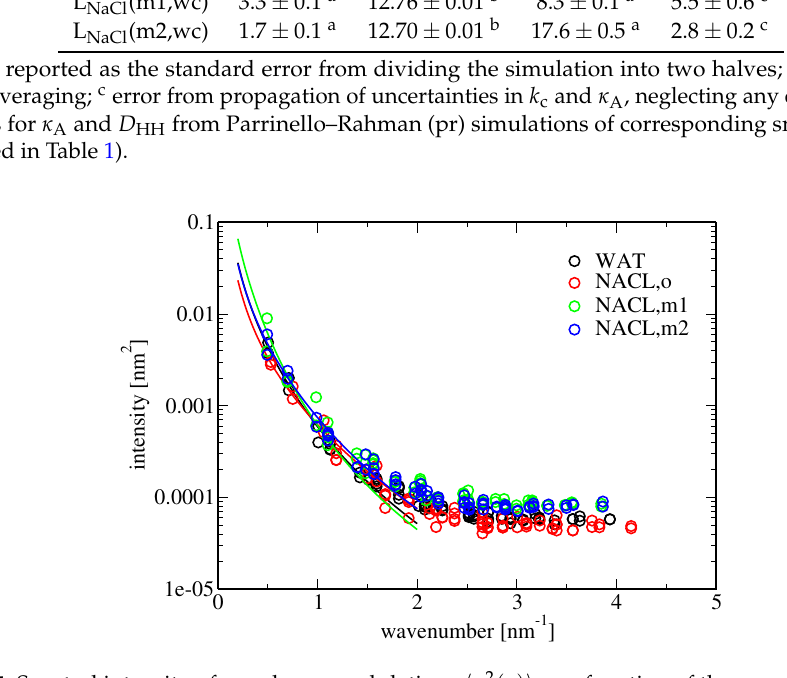
Figure 5. Spectral intensity of membrane undulations (cid:104) u 2 ( q ) (cid:105) as a function of the wavenumber q for simulations L wat (wc), L NaCl (o,wc), L NaCl (m1,wc) and L NaCl (m2,wc), shown as black, red, green and blue circles, respectively. (cid:104) u 2 ( q ) (cid:105) was obtained from a Fourier transform of the discretized undulation ˜ z ( x i , y j ) (Section 4.3.1). The data refer to the results from the analysis employing twelve grid cells per dimension. Solid lines indicate a fit according to Equation (18), carried out in the low-wavenumber regime. The simulation acronyms are explained in Table